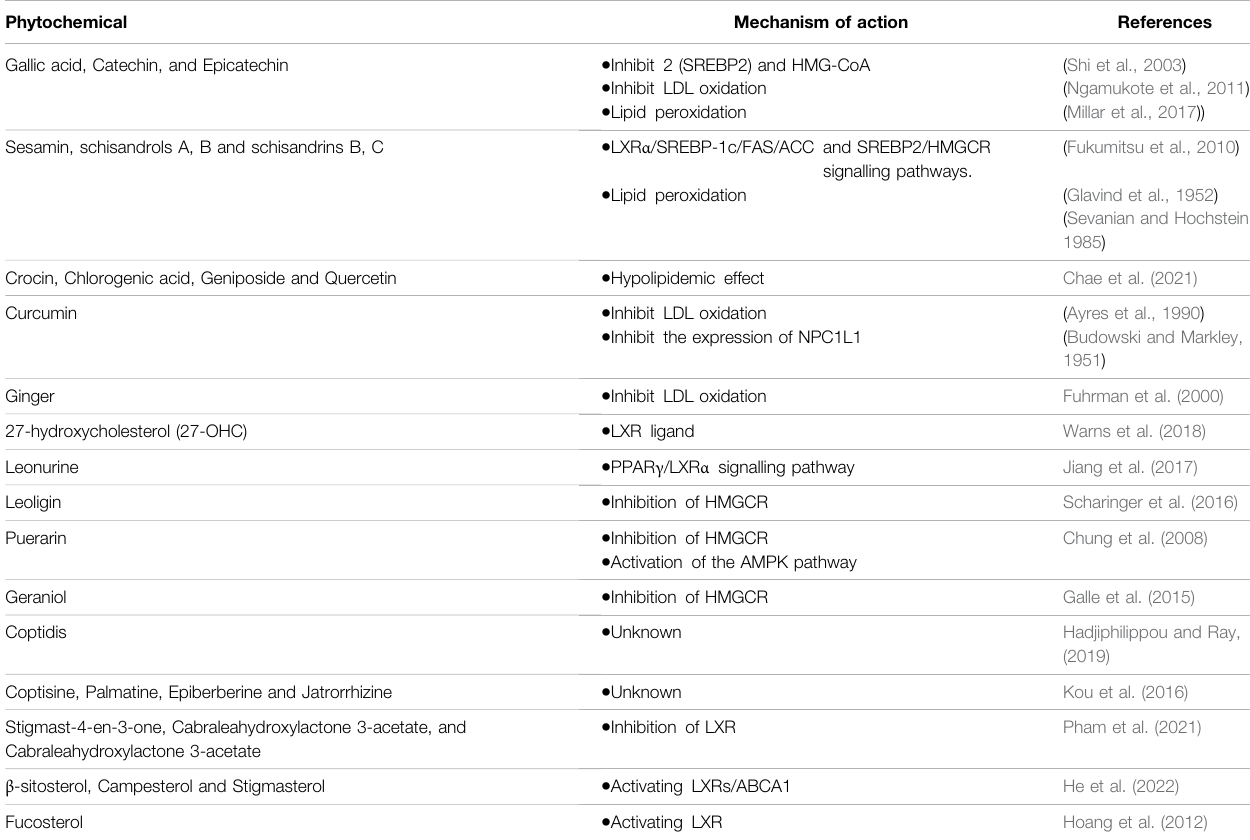
TABLE 1 | Phytochemicals regulating the mevalonate